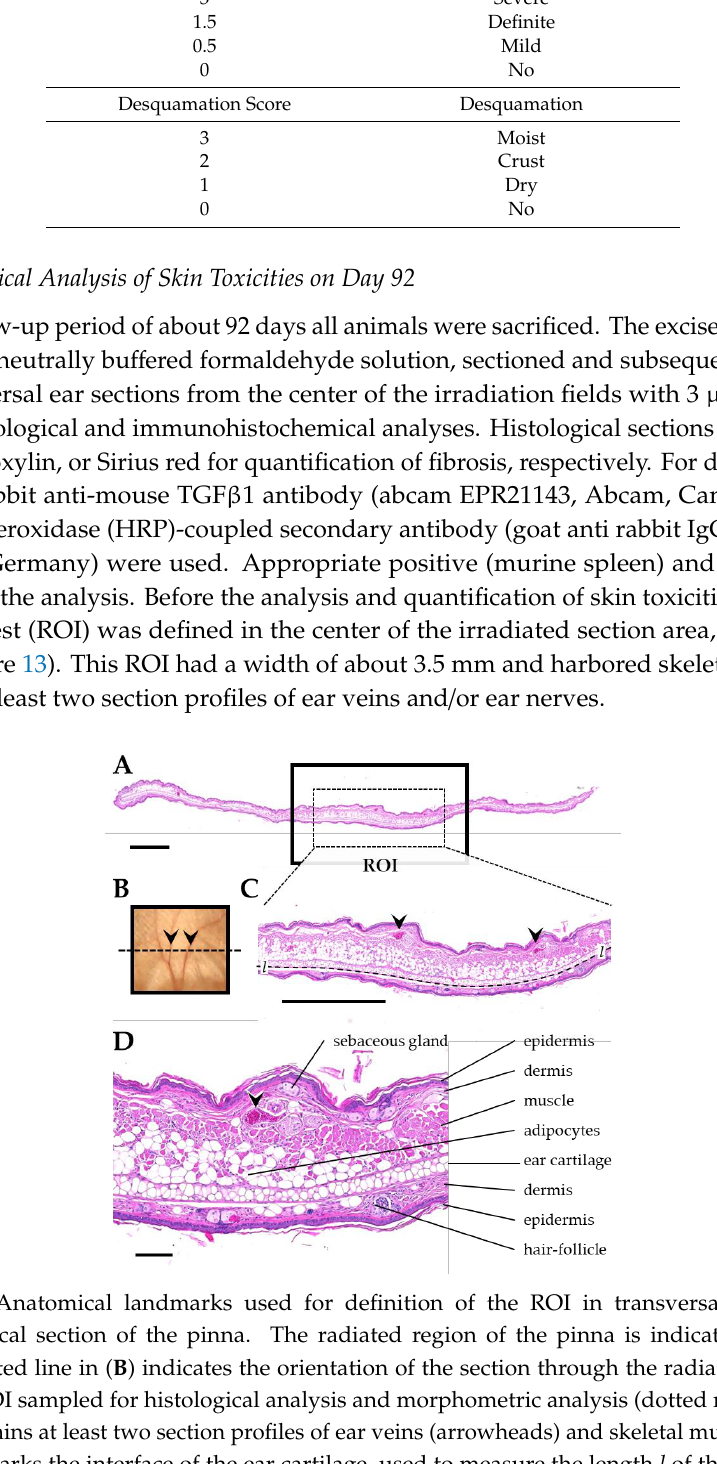
Table 3. Semi-quantitative scores for skin erythema (top) and desquamation (bottom).